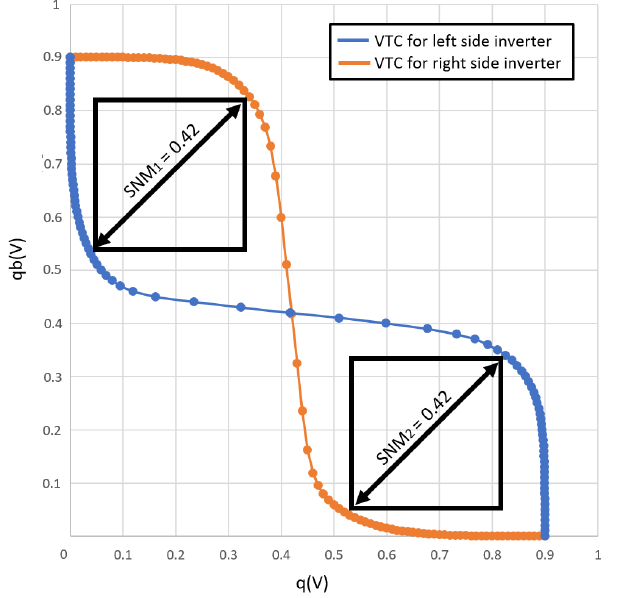
Figure 13. Hold Static Noise Margin (SNM) of the state-of-the-art 8T SRAM bit